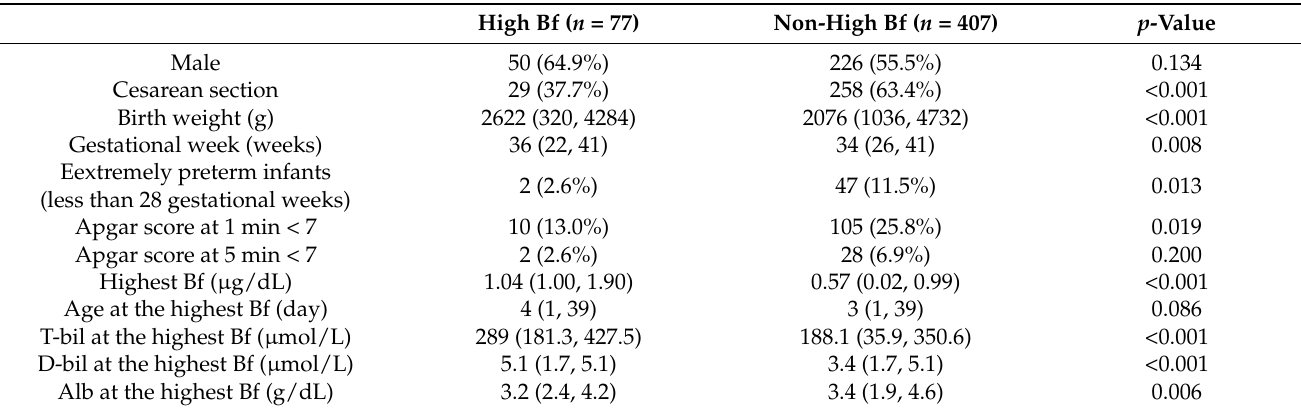
Table 1. Clinical Characteristics.